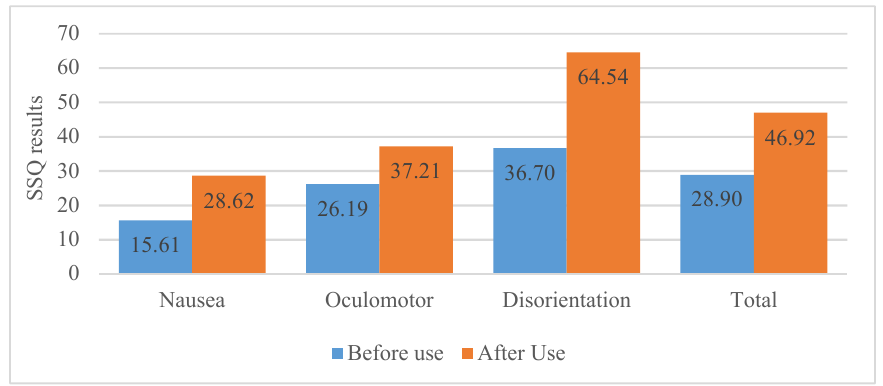
Figure 4. Results of the SSQ conducted before and after use of the application.